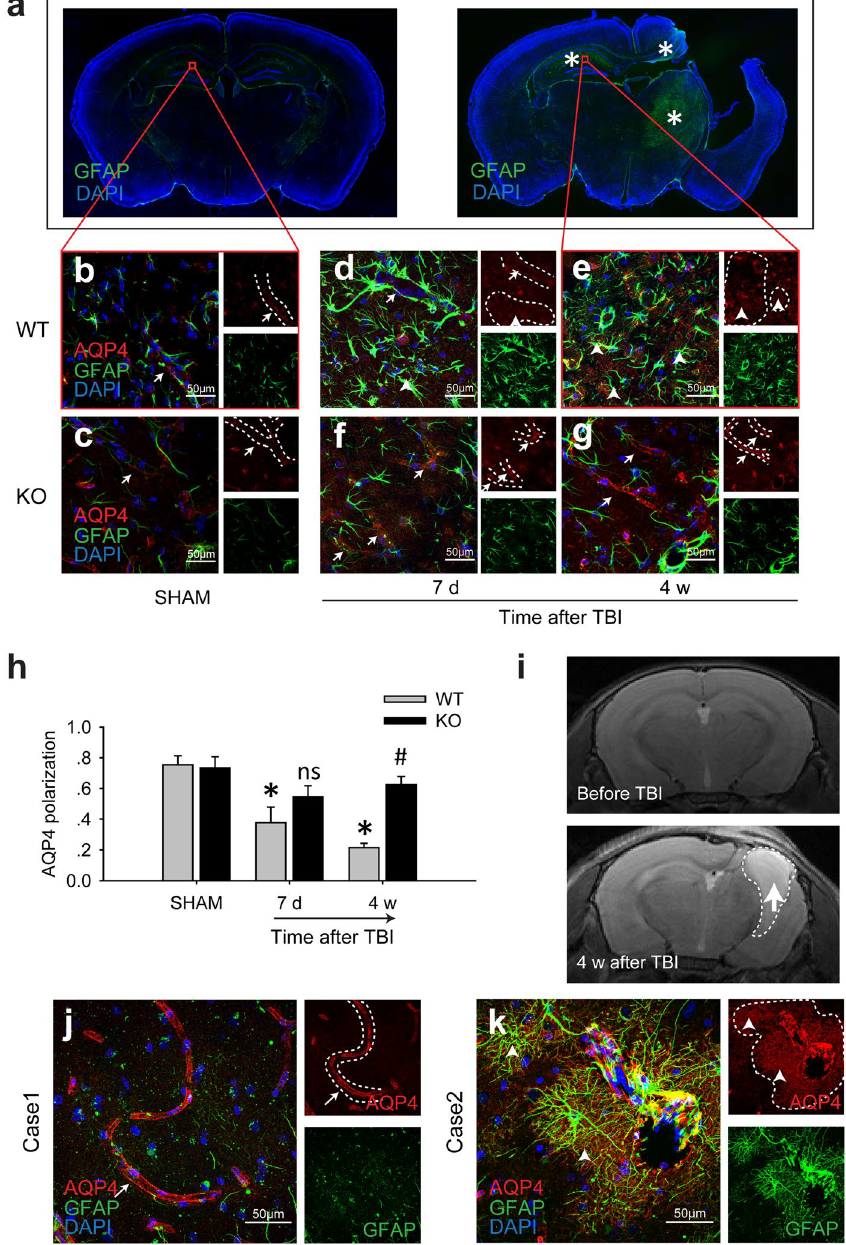
Figure 1. Loss of AQP4 polarity after brain injury in a mouse model of TBI and patients’ brains. ( a ) In the mouse TBI model, compared with the SHAM group, reactive astrogliosis (asterisk) was still obvious 4 weeks after the injury. AQP4 immunoreactivity was confined to the perivascular end feet (arrows) in the contralateral hippocampal CA1 region of the SHAM WT mice ( b ) and the SHAM A 2A R KO mice ( c ). A large proportion of AQP4 shifted to the soma and coarse processes of the GFAP-positive reactive astrocytes 7 d ( d ) and 4 weeks ( e ) after TBI. AQP4 dysregulation was alleviated by A 2A R KO ( f,g ). The arrows indicate the relative normal AQP4 distribution, and the arrowheads indicate AQP4 dysregulation. Scale bar: 50 μ m. ( h ) Quantification of AQP4 polarity in the SHAM group and 7 d and 4 weeks post-TBI group. n = 4 per group. Data represent mean ± s.e.m., * p < 0.05 compared with the WT SHAM group, ns p > 0.05 compared with the 7 d post-TBI WT group, # p < 0.05 compared with the 4 weeks post-TBI WT group, one-way ANOVA. ( i ) Normal brain structure before TBI and injured brain 4 weeks after TBI was revealed by 7.0T MRI. The dotted line indicates the range of cortical and hippocampal tissue loss. The arrow indicates the area of liquefactive necrosis. ( j,k ) GFAP (green) and AQP4 (red) were detected using immunofluorescence methods to reveal reactive astrogliosis and AQP4 dysregulation in the perihematoma brain tissues of the injured frontal cortex from TBI patients. Scale bar: 50 μ